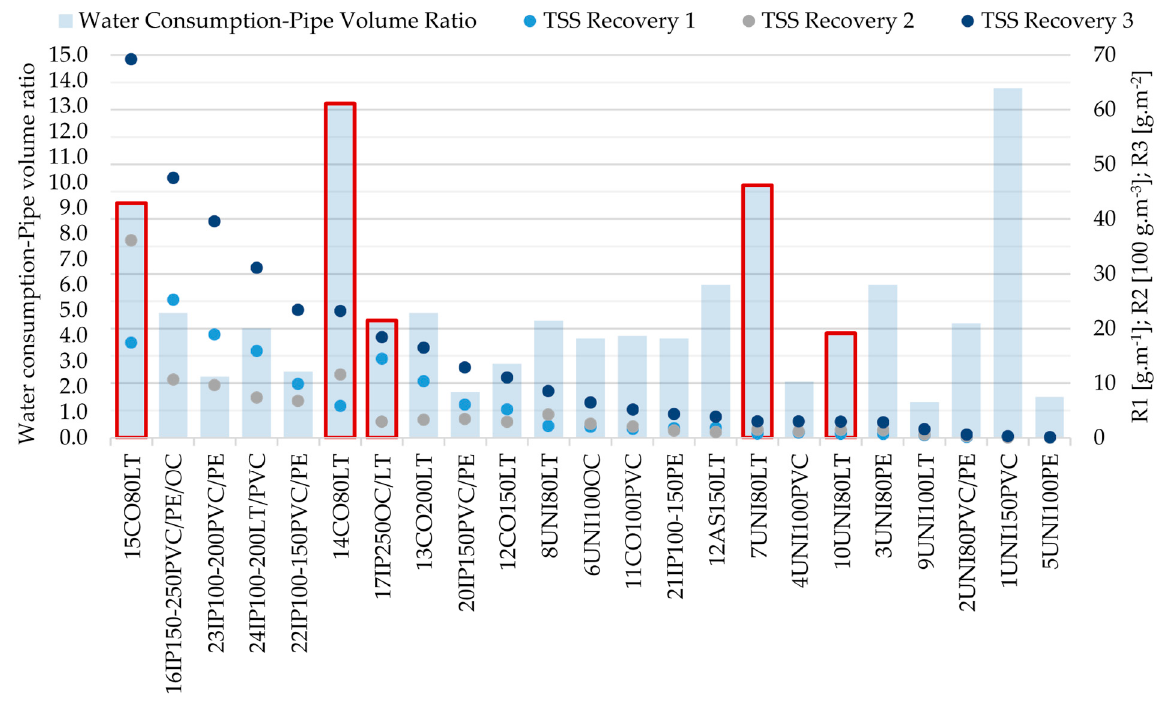
Figure 3. Total suspended solids and water consumption (red-framed columns indicate incrusted sections, for 18IP150- 200OC/LT, 19IP80-150OC/LT/PE/PVC and 25IP150-200LT/PVC-data is not available).